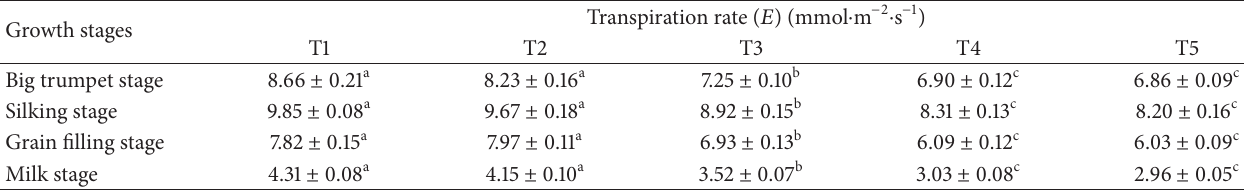
Table 3: Effects of Si application on transpiration rate ( 𝐸 ) in leaves of maize.